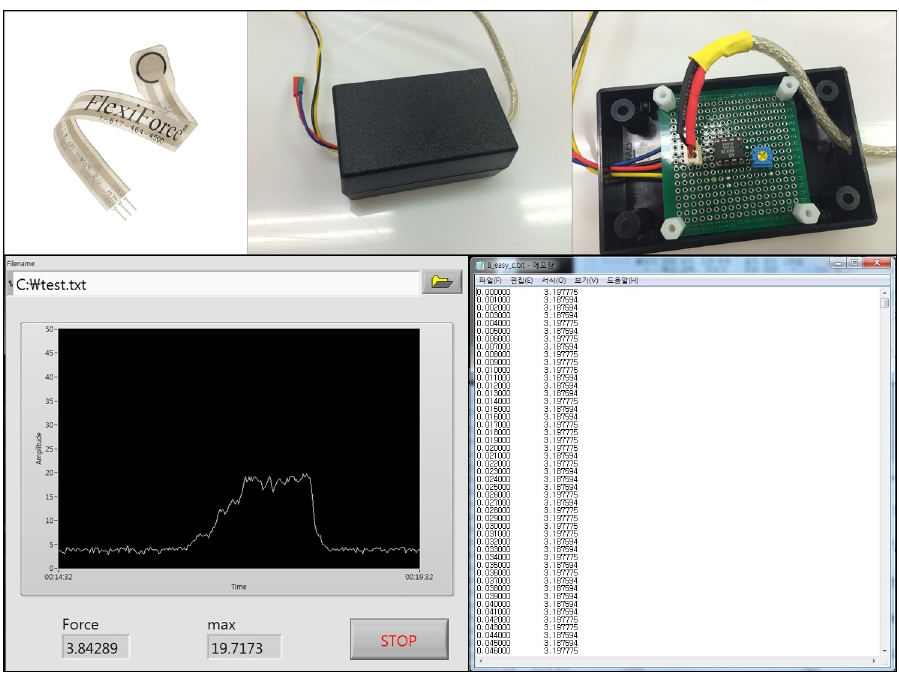
Fig 3. Peak force measurement during intubation using a FlexiForce standard load/force sensor and LabView